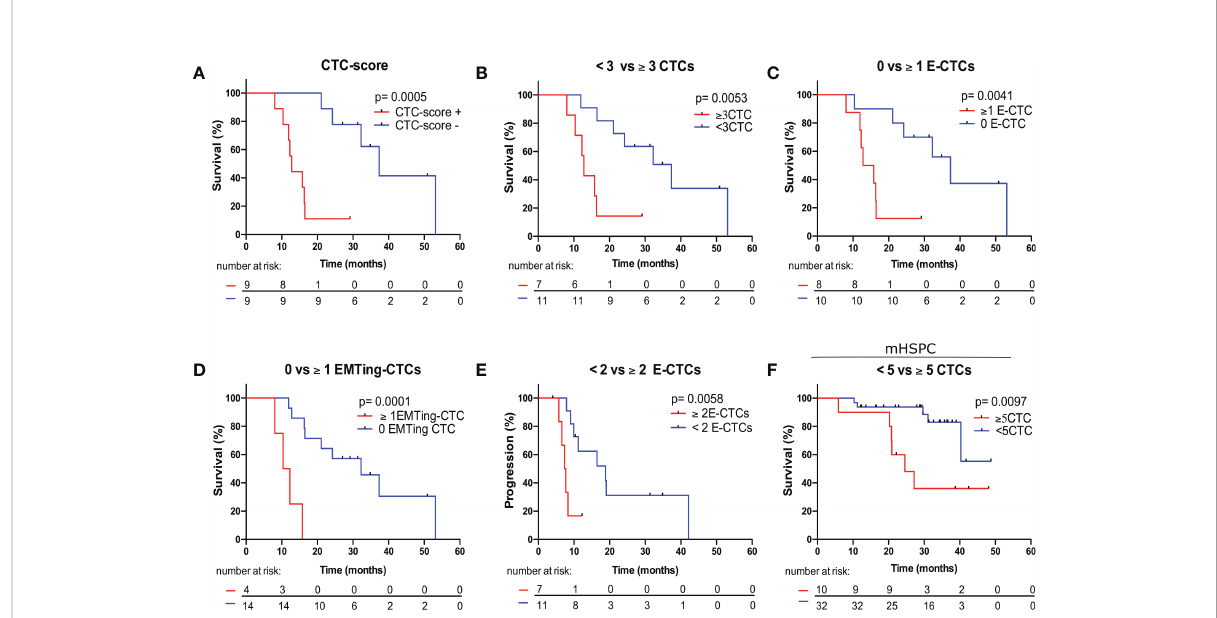
FIGURE 4 Kaplan Meier survival analysis of CTC measurements to predict OS and PFS in mCRPC and mHSPC patients. (A) mCRPC patients with a positive CTC-score experienced signi fi cantly shorter median OS compared to those with a negative CTC-score (12.80 vs. 37.33 months, HR= 5.08, p= 0.0005). (B) mCRPC patients with ≥ 3 total-CTCs experienced signi fi cantly shorter median OS compared to those with <3 total-CTCs (12.80 vs. 37.33 months, HR= 3.84, p= 0.0053). (C) mCRPC patients with ≥ 1 epithelial-CTCs experienced signi fi cantly shorter median OS compared to those with <1 epithelial-CTC (14.30 vs. 37.33 months, HR= 3.89, p= 0.0041). (D) mCRPC patients with ≥ 1 EMTing-CTCs experienced signi fi cantly shorter median OS compared to those with <1 EMTing-CTC (11.32 vs. 32.37 months, HR= 6.73, p= 0.0001). (E) mCRPC patients with ≥ 2 epithelial-CTCs experienced signi fi cantly shorter median PFS compared to those with <2 epithelial-CTC (7.52 vs. 18.83 months, HR= 3.93, p= 0.0058). (F) mHSPC patients with ≥ 5 CTCs experienced signi fi cantly shorter median OS compared to those with <5 CTCs (24.57 vs unde fi ned months, HR= 4.14, p=